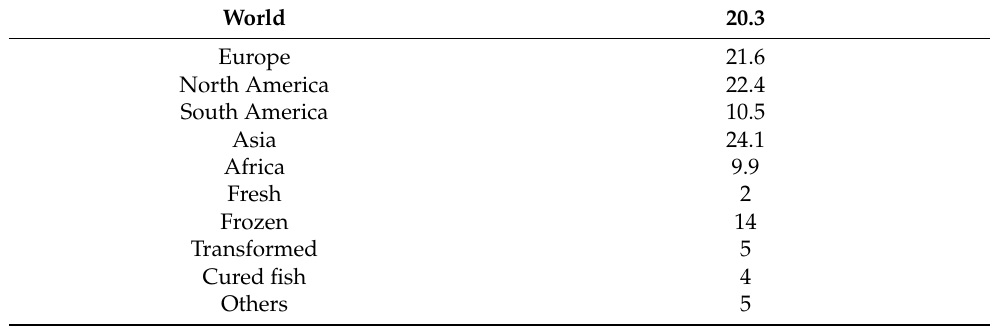
Table 12. Total per capita fish consumption (kg/year) and product types traded (live weight MT) in developed countries in 2018. World 20.3 Europe 21.6 North America 22.4 South America 10.5 Asia 24.1 Africa 9.9 Fresh 2 Frozen 14 Transformed 5 Cured fish 4 5